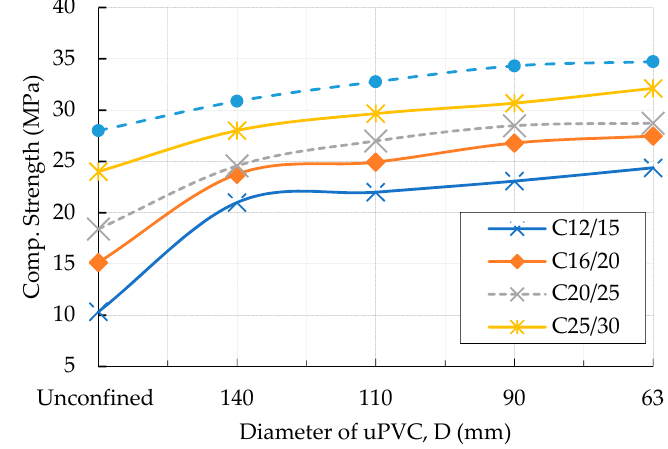
Figure 13. Effect of pipe diameter on strength of uPVC confined concrete cylinders.